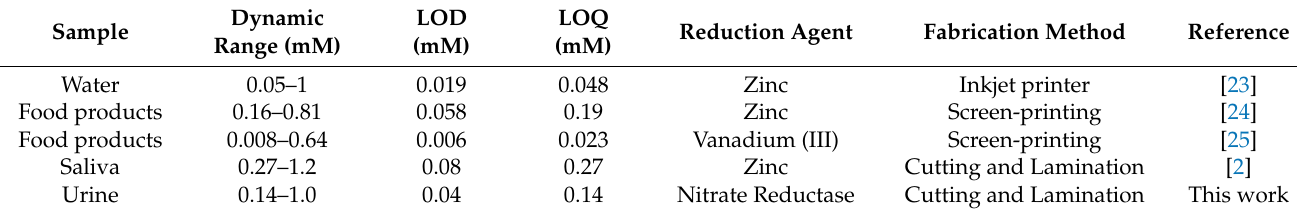
Table 5. Summary of the characteristics of the developed µ PAD in comparison with previously described devices; LOD, limit of detection; LOQ, limit of